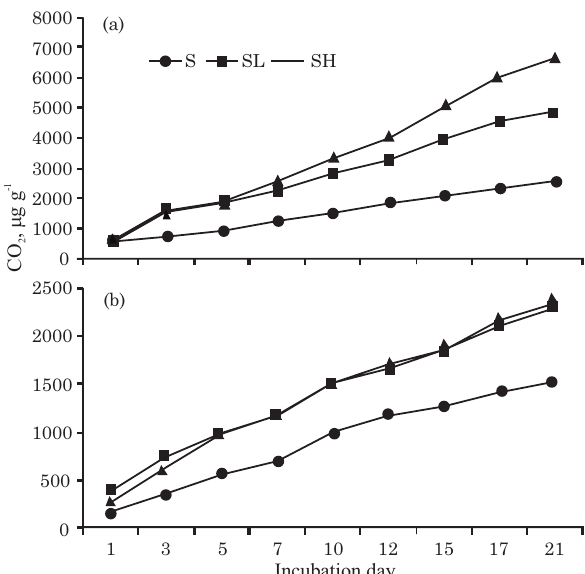
Figure 4. Curves of cumulative CO 2 from inorganic fertilizer-soil (S), sewage sludge-treated soil, low rate (SL) and sewage sludge-treated soil, high rate (SH), during an incubation period of 21 days: (a) one day, (b) 230 days after sewage sludge